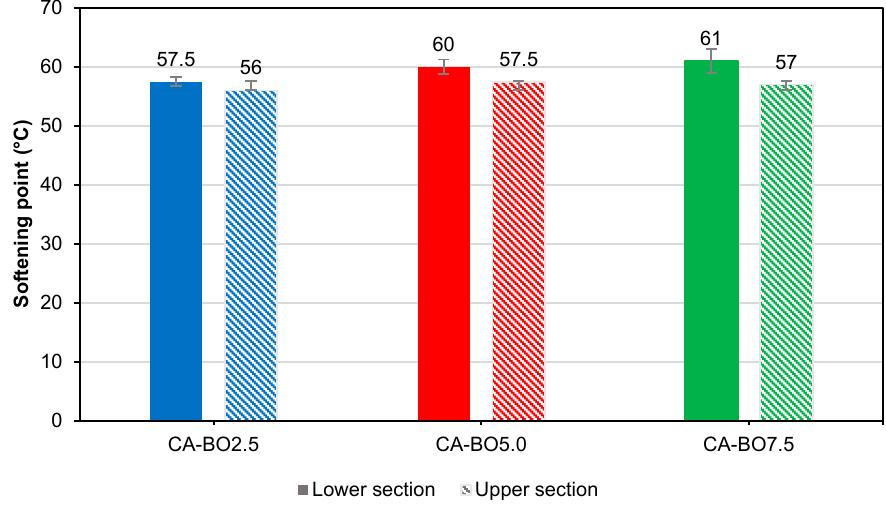
Figure 12. Storage stability of samples.